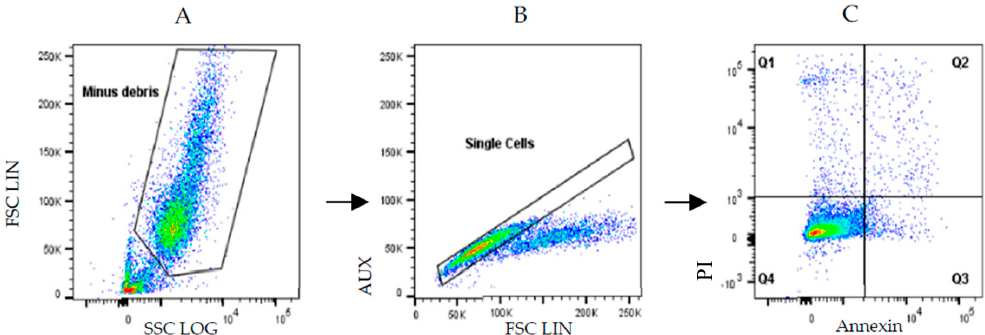
Figure 11. Flow cytometry gating strategy used to evaluate apoptosis/necrosis in MCF-7 cells. ( A ) The gate separated MCF-7 cells from cellular debris, whereas in ( B ) single cells are gated, thus excluding aggregates. ( C ) Target cells were distinguished based on PI/Annexin V staining. In Q1 + Q2 are represented cells in necrosis/late apoptosis, in Q3 are represented cells that are in early apoptosis and living cells are represented in Q4. SCC: side-scattered light; FSC: forward-scattered light; AUX: auxiliar; LIN: linear scale; Log: logarithimic scale; PI: propidium iodide